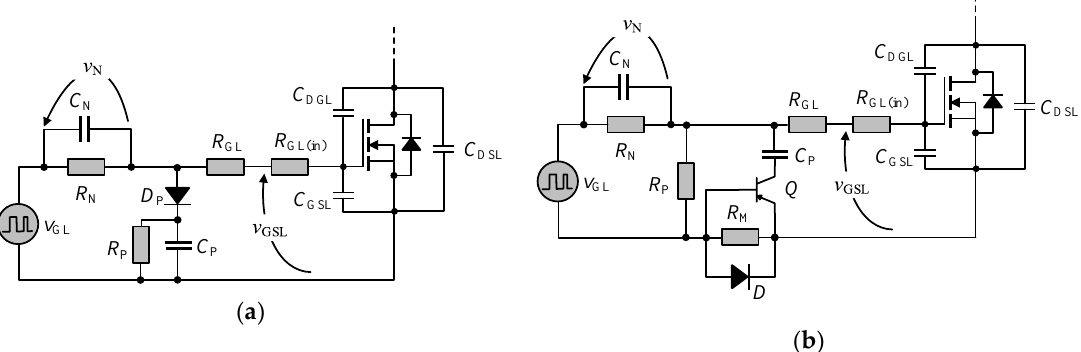
Figure 2 . Gate driver for SiC MOSFET with ( a ) RCD level shifter [15] ( b ) voltage divider based level shifter [28].